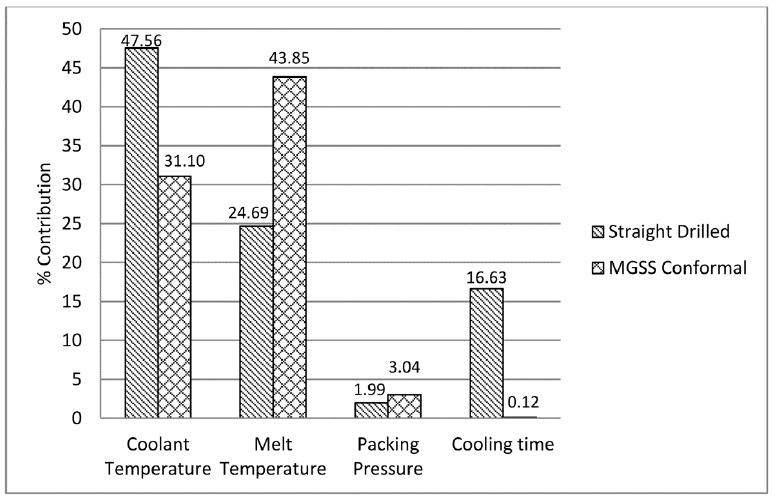
Figure 6. Parameters contribution percentage against warpage for straight drilled and MGSS con- formal cooling